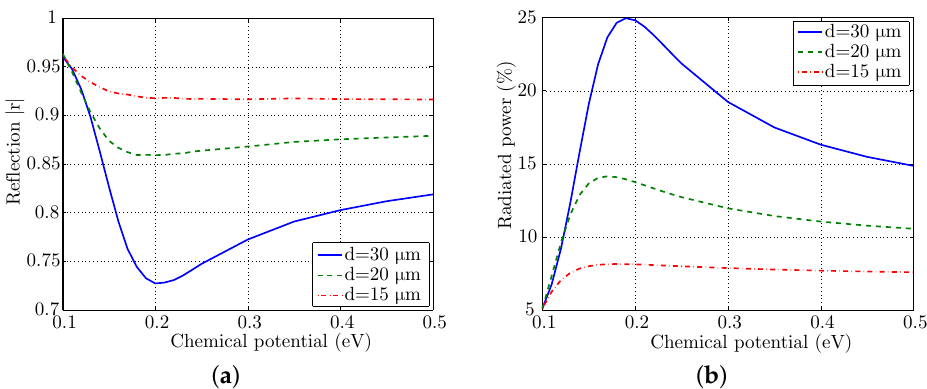
Figure 6. Surface wave ( a ) reflection coefficient and ( b ) power flow to free-space for a graphene layer of µ c = 0.1eV with matching component termination of different chemical potential.